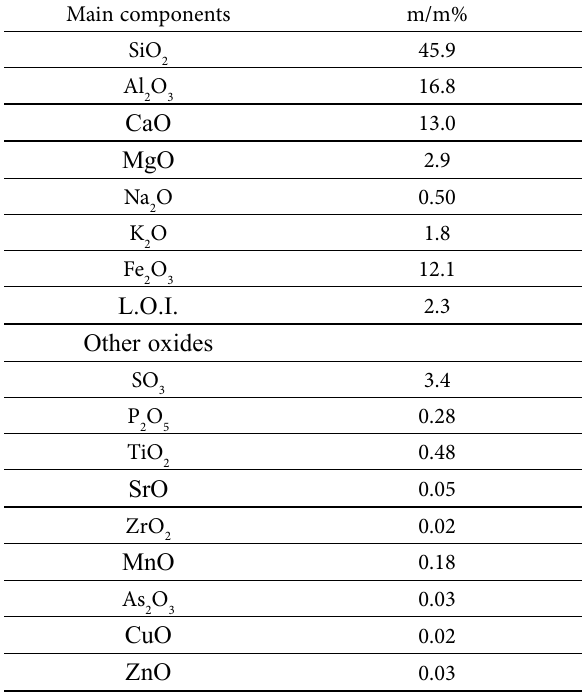
Table 1. Chemical composition of the fly ash from (XRF analysis) Main components